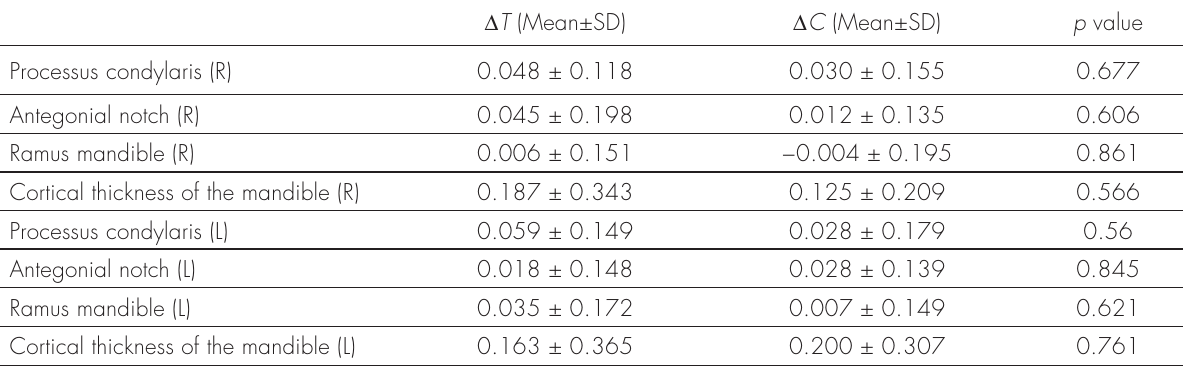
Table III. Comparisons of T1–T2 (Pretreatment – Posttreatment) and C1–C2 (Precontrol – Postcontrol) with independent t